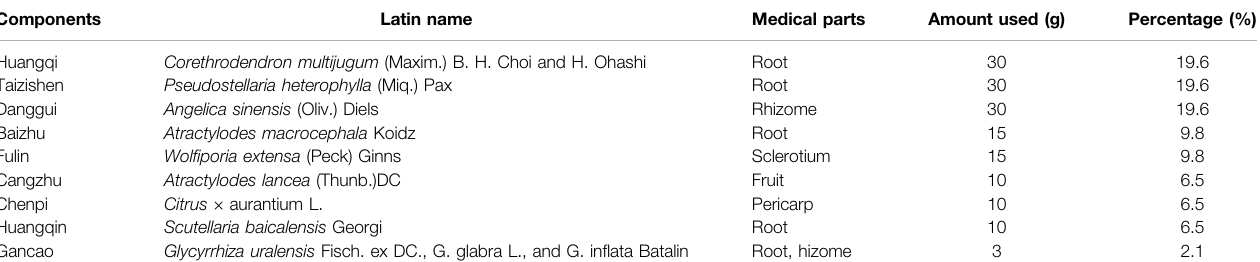
TABLE 1 | The composition of traditional Chinese medicine in Yi-Qi-Jian-Pi Formula (YQJPF). Components